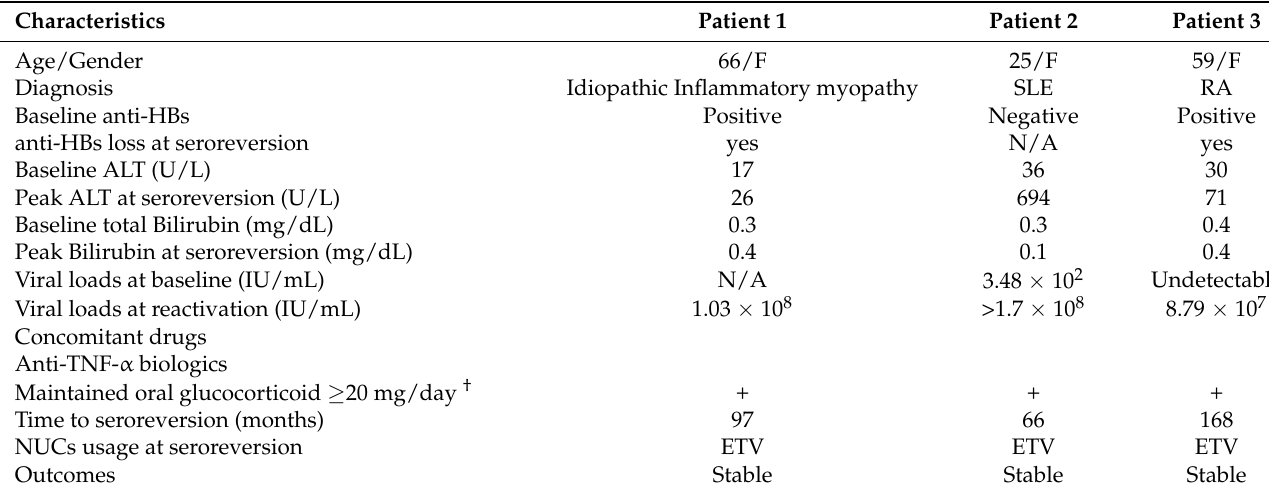
Table 4. Clinical, serological and virological characteristics of rheumatic patients with HBsAg seroreversion after receiving glucocorticoid pulse